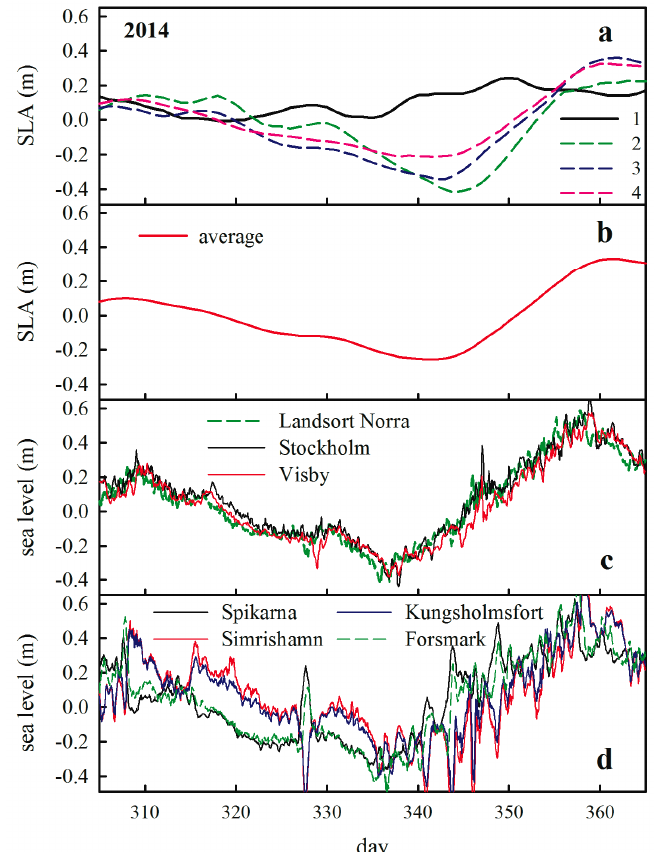
Figure 4. Time series of SLA compared with tide gauge data at selected stations during Major Baltic Inflow in 2014: ( a ) time series of SLA at pixels 1–4. ( b ) Time series of SLA averaged over the Baltic Proper. ( c ) Time series of the sea level measured at Landsort Norra, Stockholm, and Visby. ( d ) Time series of the sea level measured at Simrishamn, Kungsholmsfort, and Forsmark. See Table 2 for geographical coordinates of the stations.